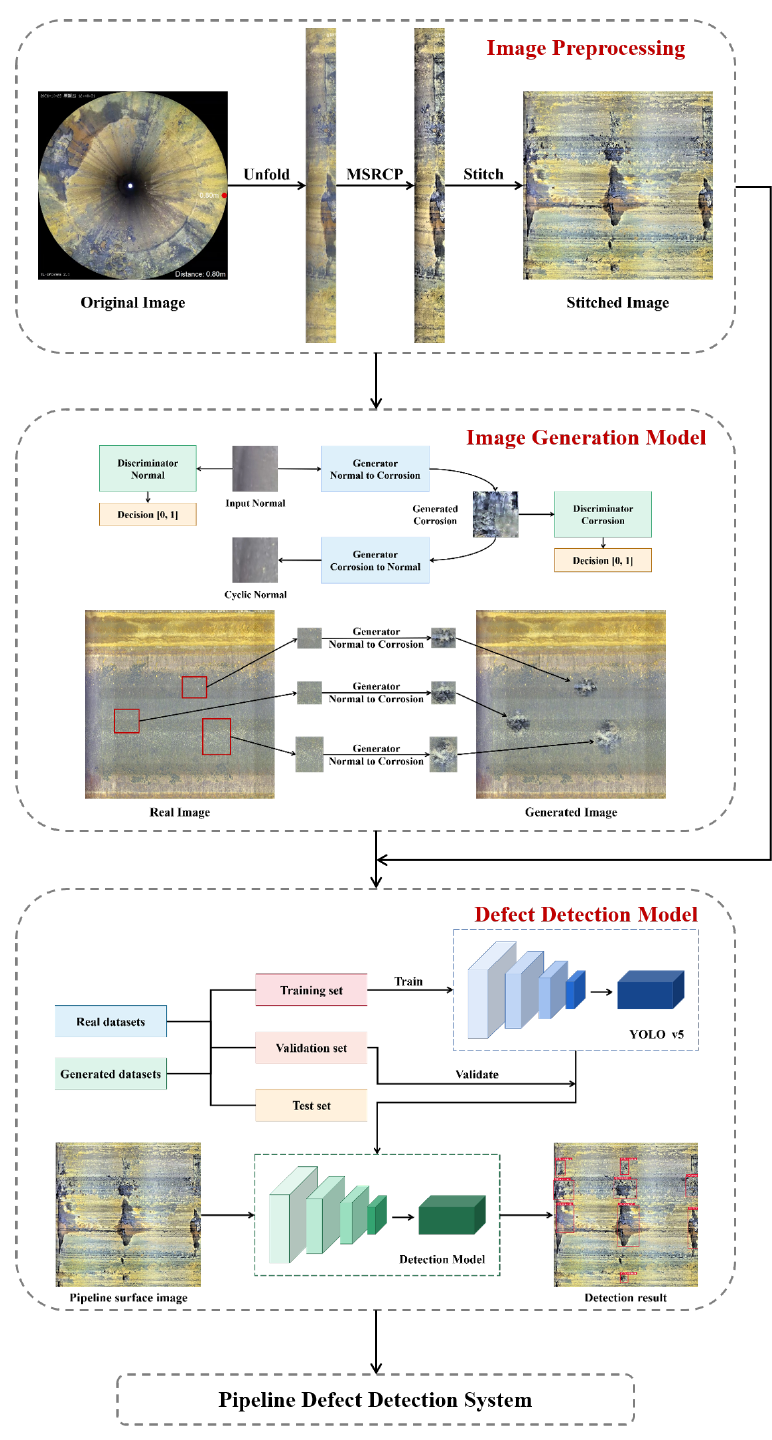
Figure 1. The structure of the defect detection